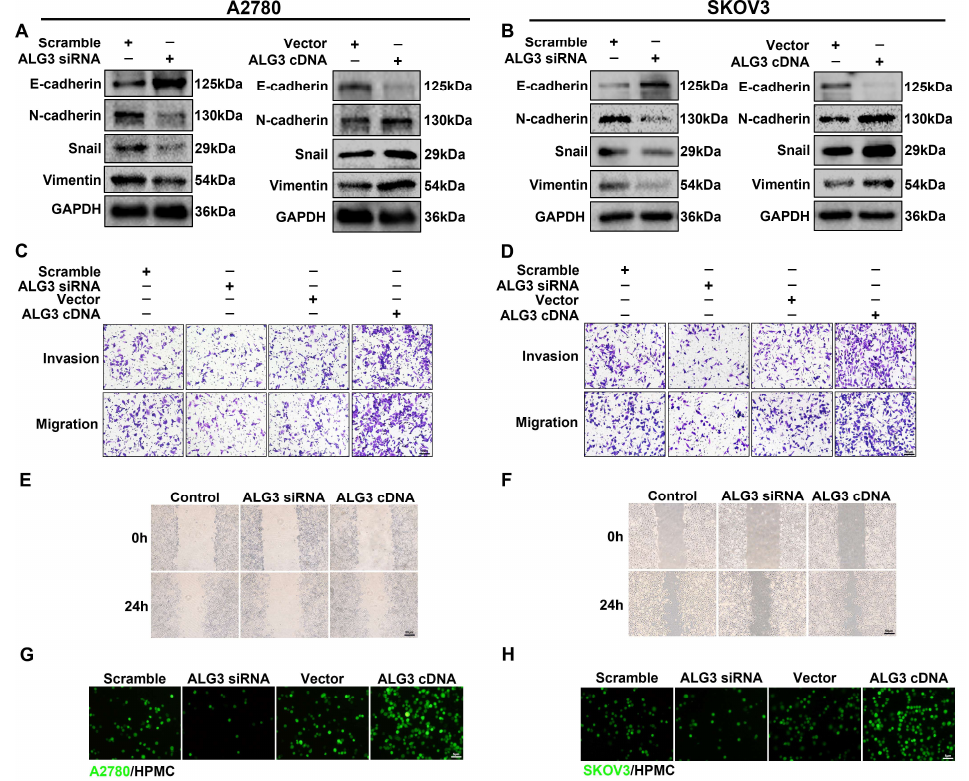
Figure 4. ALG3 enhances the metastasis capacity of ovarian cancer cells. ( A , B ) Western blot analysis of EMT markers (E-cadherin, N-cadherin, Snail and Vimentin) expressed in A2780 ( A ) and SKOV3 ( B ) cells after transfection with scramble siRNA, ALG3 siRNA, vector and ALG3 cDNA. ( C , D ) The migration and invasion potential detected by transwell migration/Matrigel invasion assay. ( E , F ) The migration ability detected by scratch assay. ( G , H ) Representative images of fluorescently labeled A2780 ( G ) and SKOV3 ( H ) cells adhering to HPMCs. Bars represent 5 μm ( G , H ), 10 μm ( C , D ) and 50 μm ( E , F ).